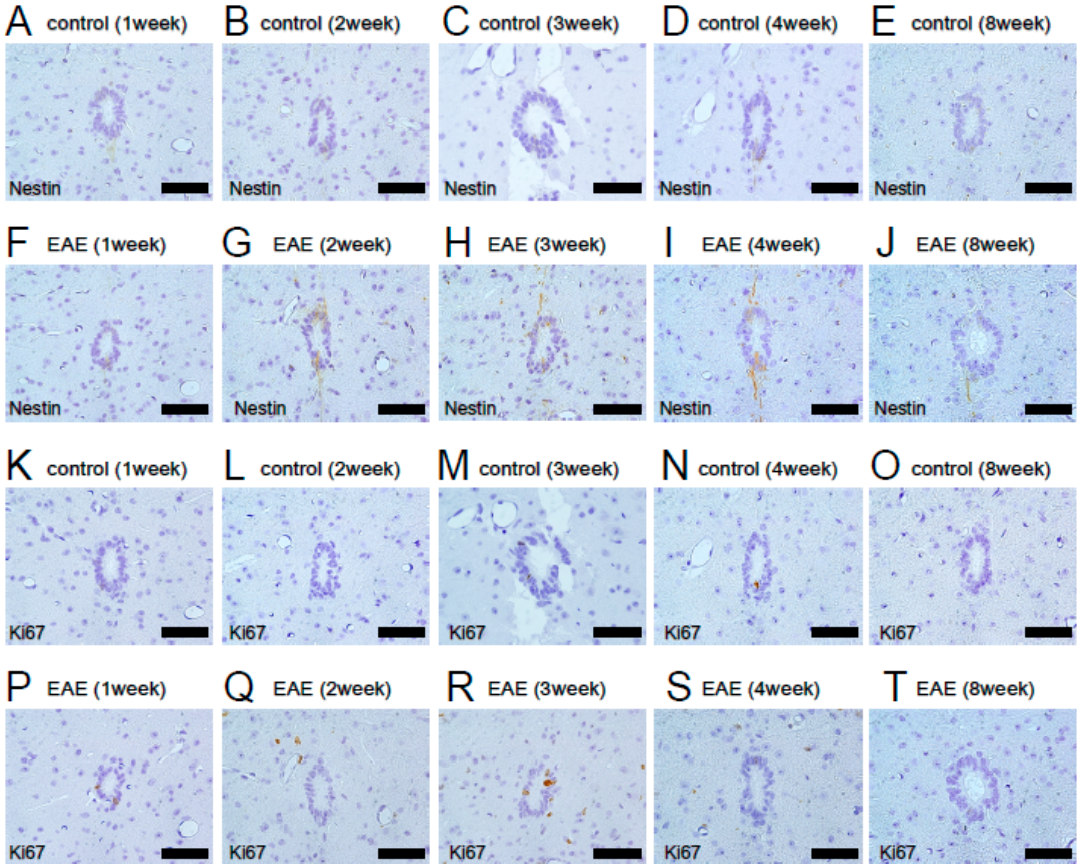
Figure 5. Immunohistochemical analysis for Nestin ( A – J ) and Ki67 ( K – T ) of central canal ependymal cells at 1 ( A , F , K , and P ), 2 ( B , G , L , and Q ), 3 ( C , H , M , and R ), 4 ( D , I , N , and S ), and 8 weeks ( E , J ,